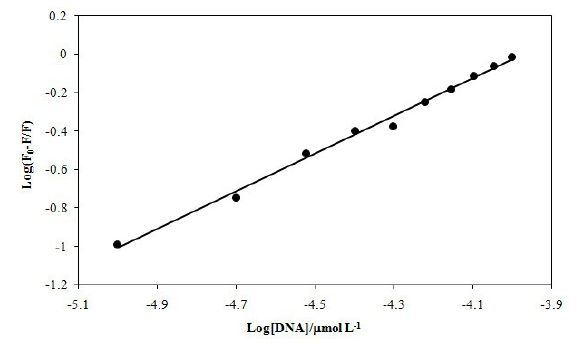
Figure 9. Plot of log [(F −F)/F] versus log [Q] for the interaction of EPR with DNA. 0 ＝ 50.0 μmol L -1 in phosphate buffer (0.1 mol L -1 , pH 7.4) at excitation wavelength of C EPR 482 nm.